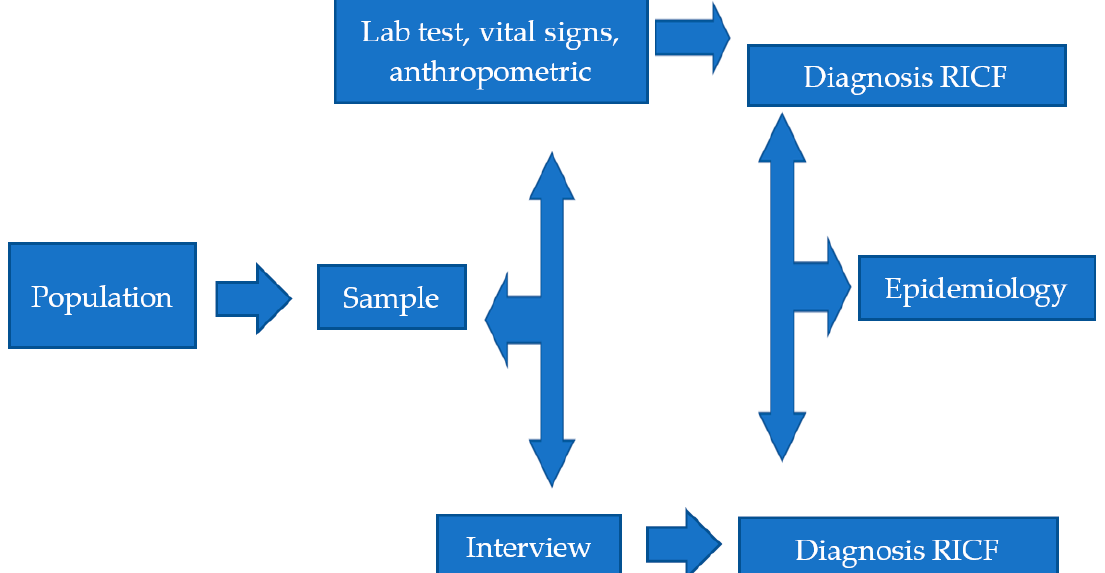
Figure 1. Study methodology flowchart. (RICF: risk of impaired cardiovascular function).